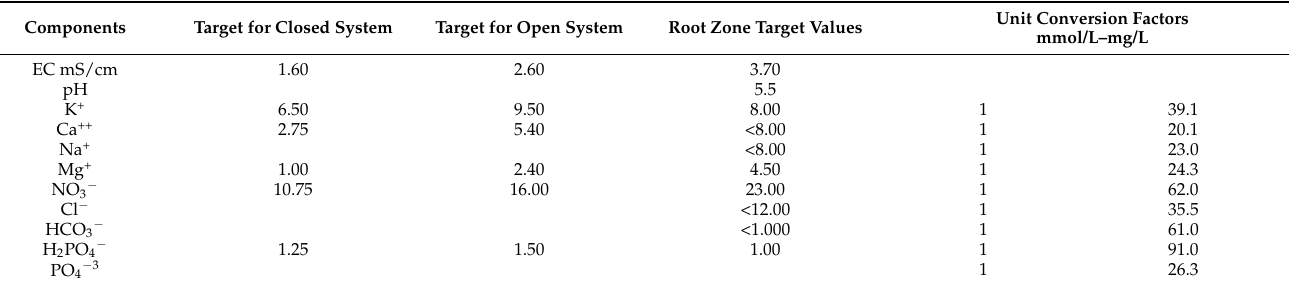
Table 3. Tomato plant suggested limits for common nutrients, including conversion